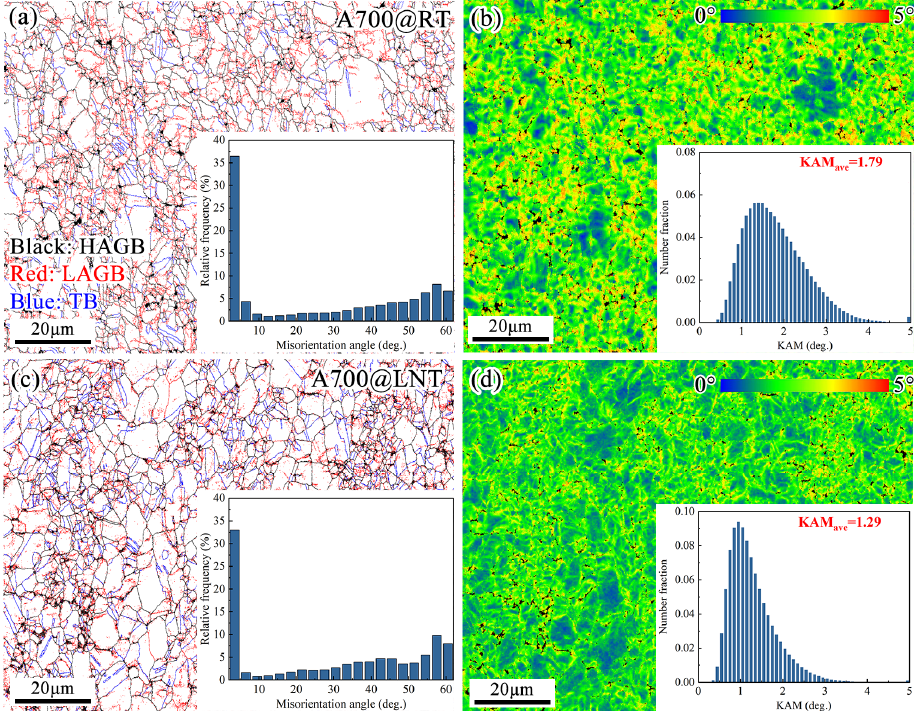
Figure 8. EBSD characterization of deformed microstructures underneath fracture surface of A700 Charpy V-notch impact specimen at ( a , b ) RT and ( c , d ) LNT. ( a , c ) Grain boundary maps and misorientation angle statistical results (insets). ( b , d ) Corresponding KAM maps and statistical KAM data (insets).